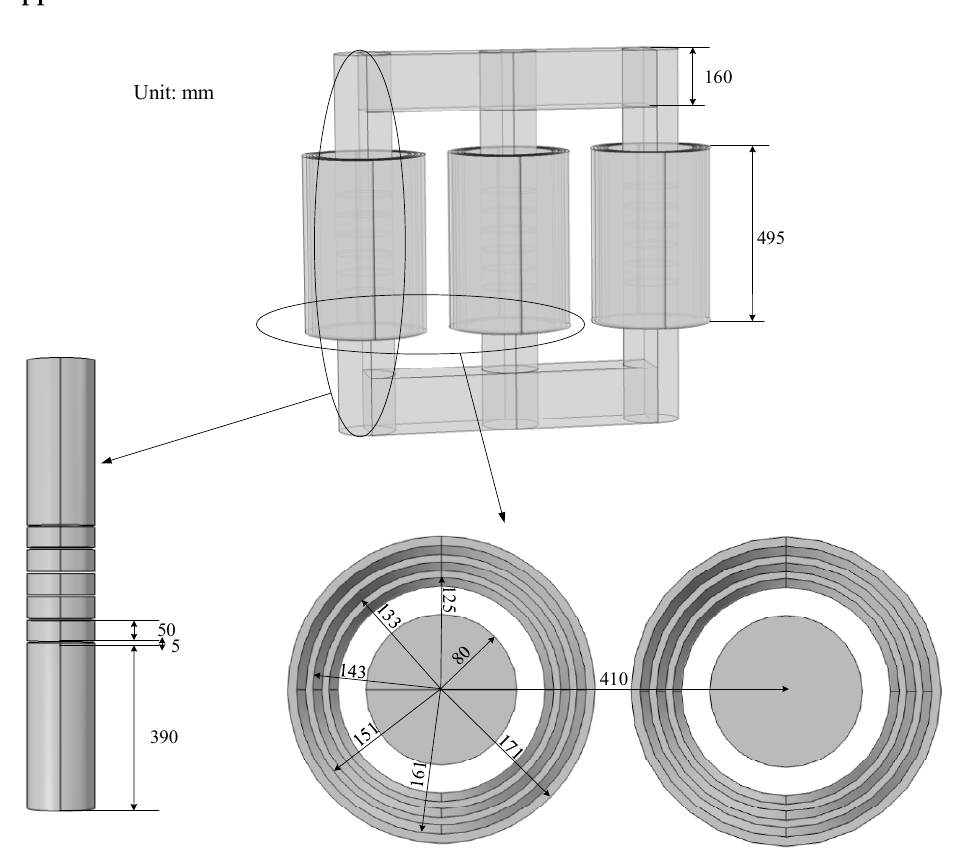
Figure A1. The dimensions of the model geometric.